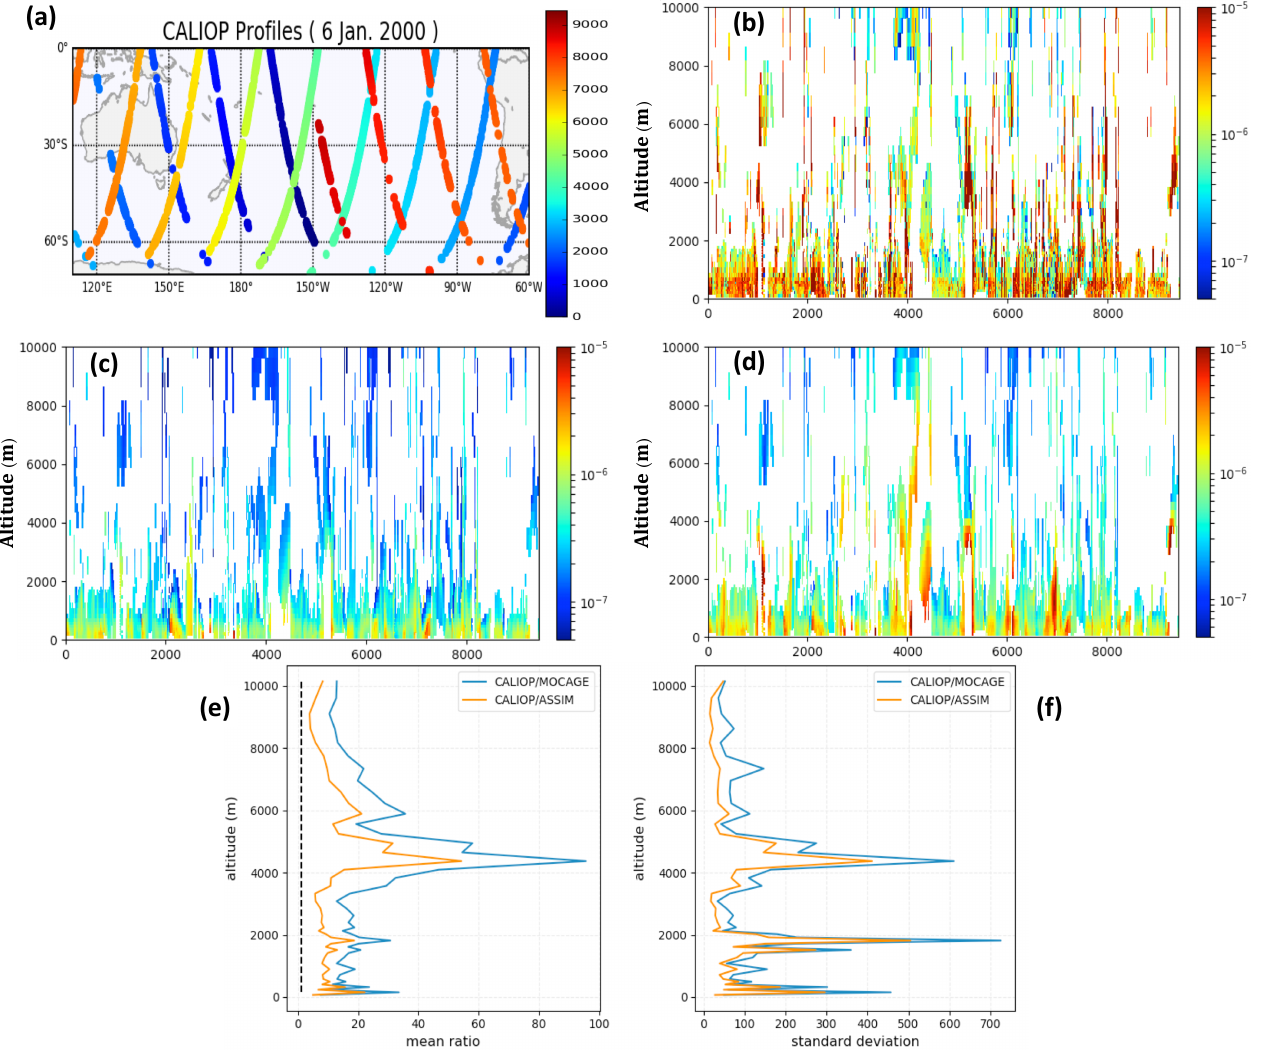
Figure 9. ( a ) The measurement orbits of the CALIOP instrument during 6 January 2020 over the Australian region. The colour code refers to the number of vertical profiles from the beginning of measurement. ( b ) The vertical profiles of CALIOP observations in terms of backscatter coefficient (m − 1 · sr − 1 ). The x-axis corresponds to the number of vertical profiles shown in ( a ). The corresponding profiles as for ( b ) from the model free run and the assimilated product are given in ( c , d ), respectively. ( e ) The mean vertical profiles of the ratios CALIOP (cyan), and CALIOP (orange), respectively. MOCAGE ASSIMILATION The corresponding vertical profiles of the standard deviations are presented in ( f ). The dashed vertical line in ( e ) represents the mean ratio of